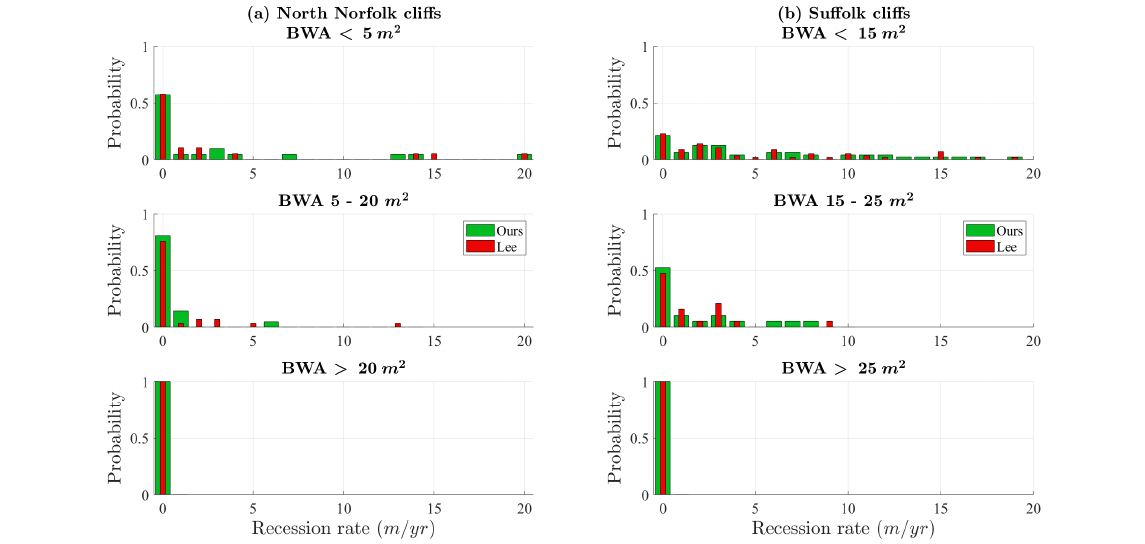
Figure 6. Annual scale probability distribution for recession rates sub-divided into different BWA ranges for [3] and our results for North Norfolk ( a ) and Suffolk ( b ) cliffs. The probability histogram is based on intervals of 1 m/year for recession rates. We used the same BWA zone limits of [3] based on the data for a more accurate